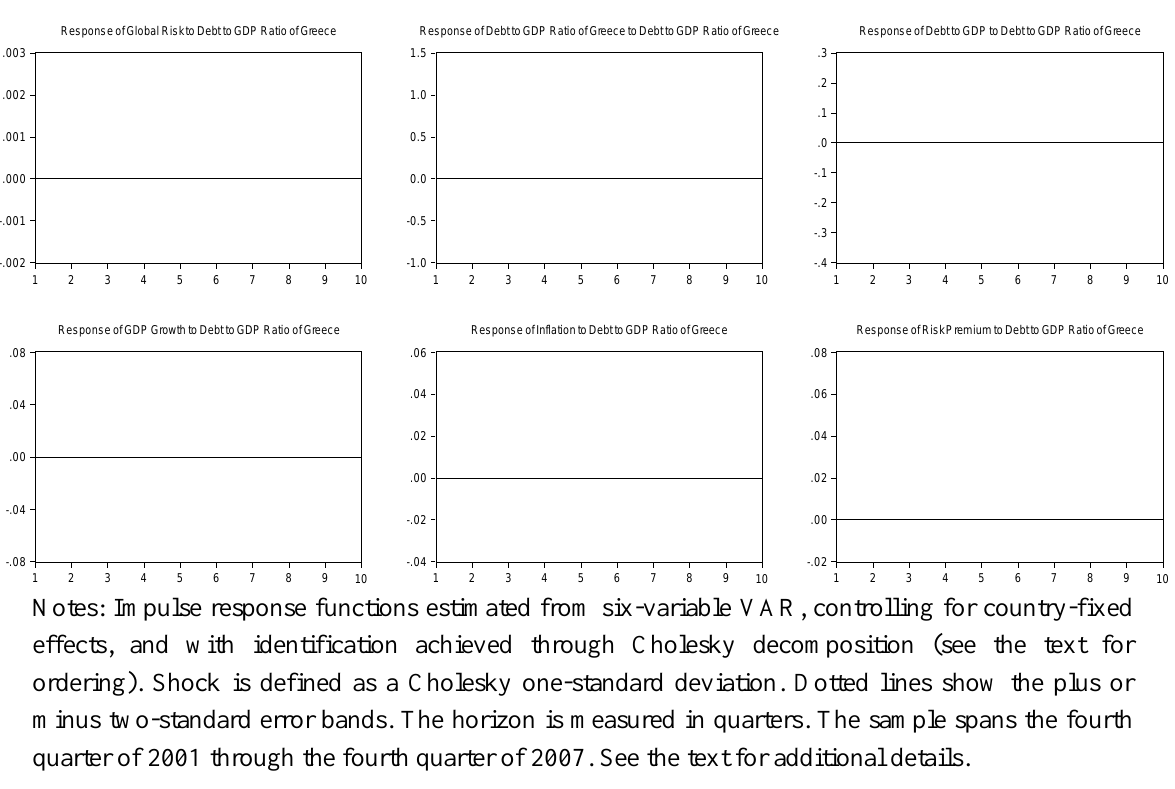
Figure 12. Pre-crisis response of EMU countries to a shock to the Greek debt-to-GDP ratio: 2001–2007.